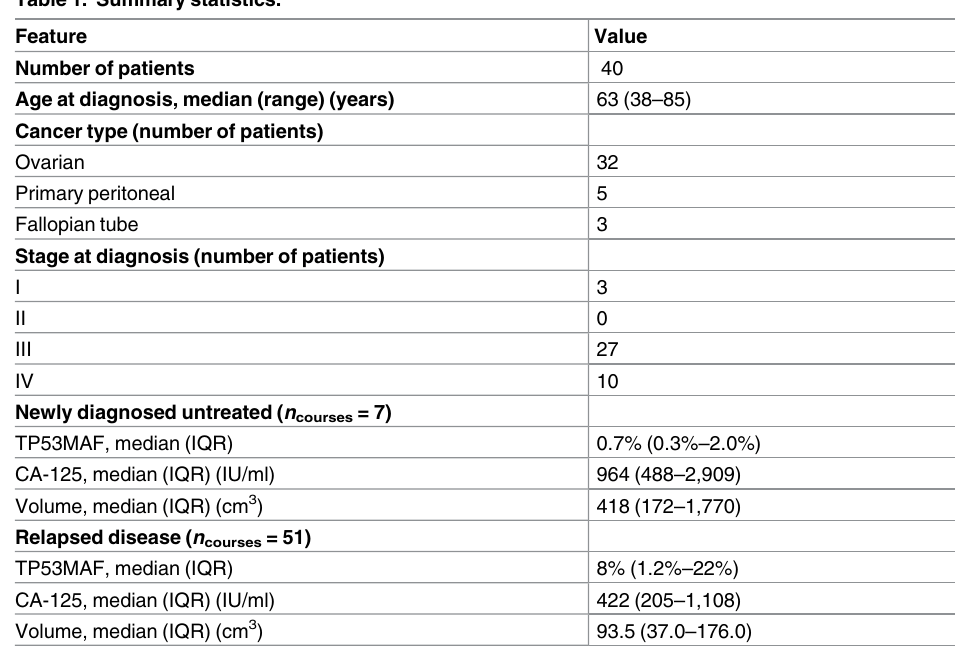
Table 1. Summary